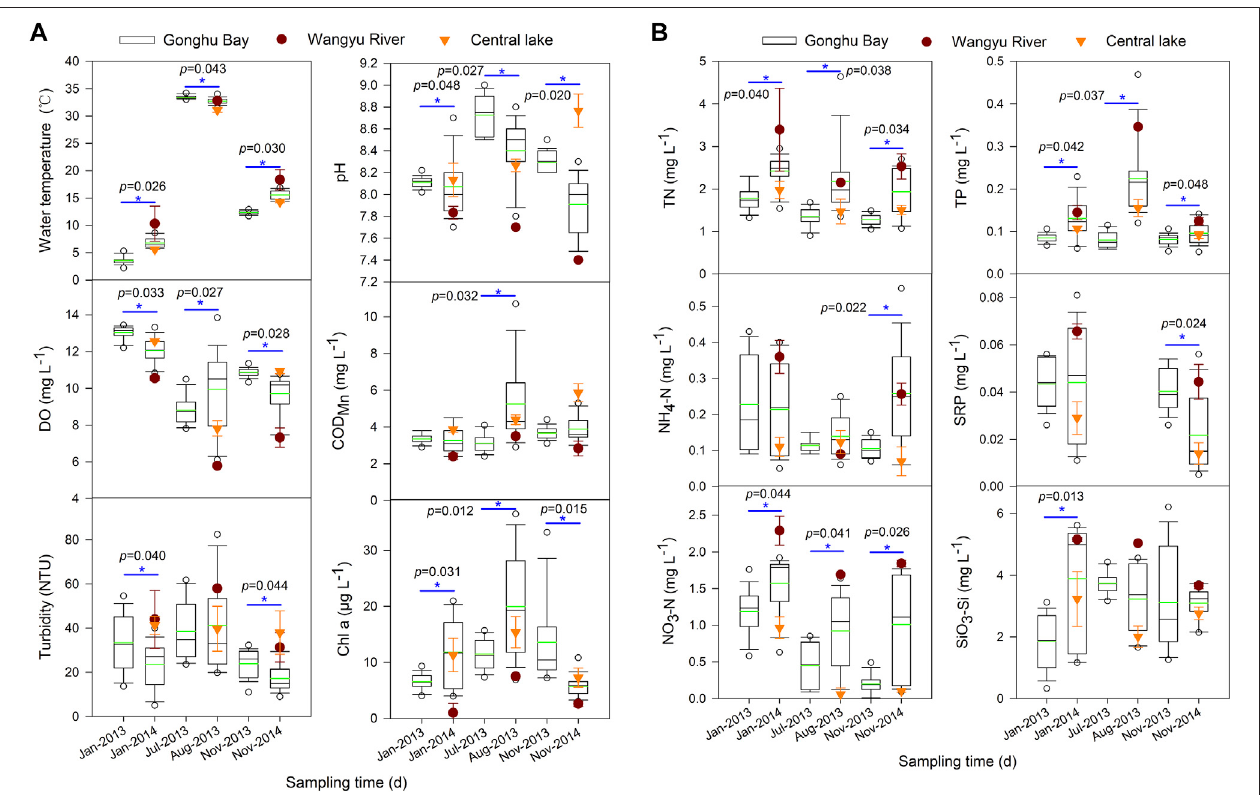
FIGURE3 | The comparisonsin mean values ofthe 12physicochemical parameters between the same seasons during waterdiversionand non-diversion periods from 2013to2014(DO,dissolvedoxygen;SiO 3 -Si,activesilicate; NO 3 -N,nitrate;NH 3 -N,ammonia; TN,totalnitrogen; TP,totalphosphorus;Temp,watertemperature; Chl a, chlorophyll a; COD Mn , permanganate index; Jan, Aug, and Nov are the abbreviations of January, August, and November, respectively, the asterisk means signi fi cant difference in parameters between the water diversion and non-diversion periods in the same season; Signi fi cant p values between the water diversion and non-diversion periods in the same season are shown in the fi gure; the green line means the mean value in the physicochemical parameter from the 15 sites in the Gonghu